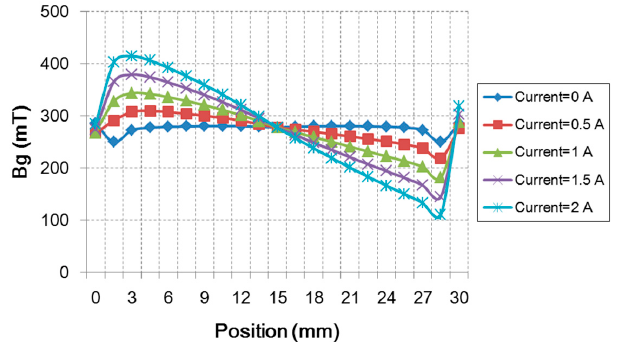
Figure 6. Air gap flux density corresponding to the position of the mover.